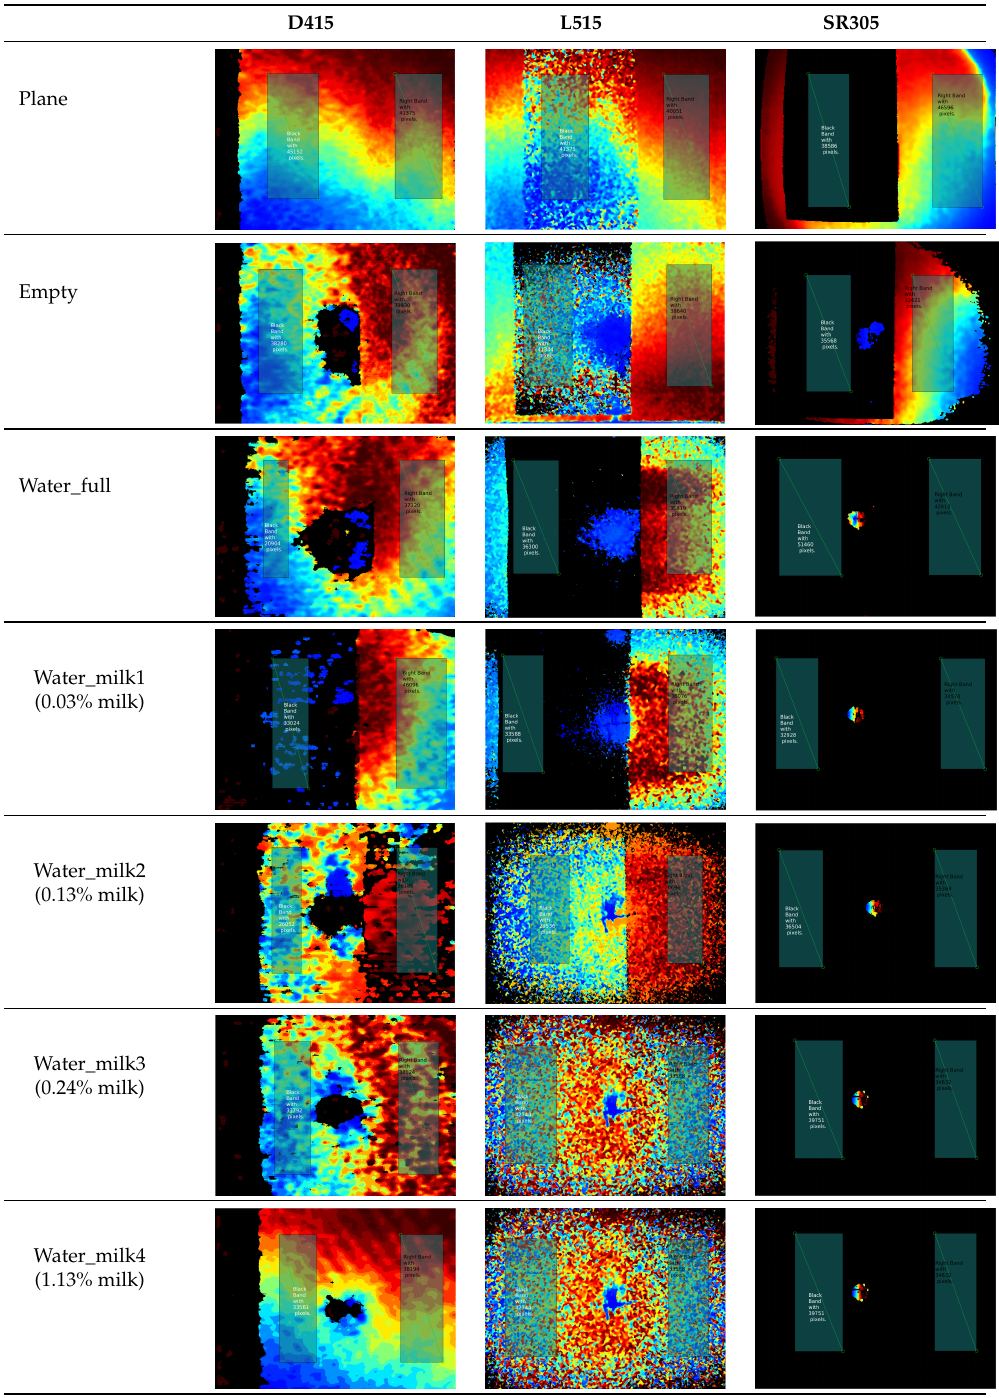
Table A1. Depth frames acquired by the D415, L515, and SR305 cameras for seven different trans- parency scenarios and the segmented bands ( rb and lb